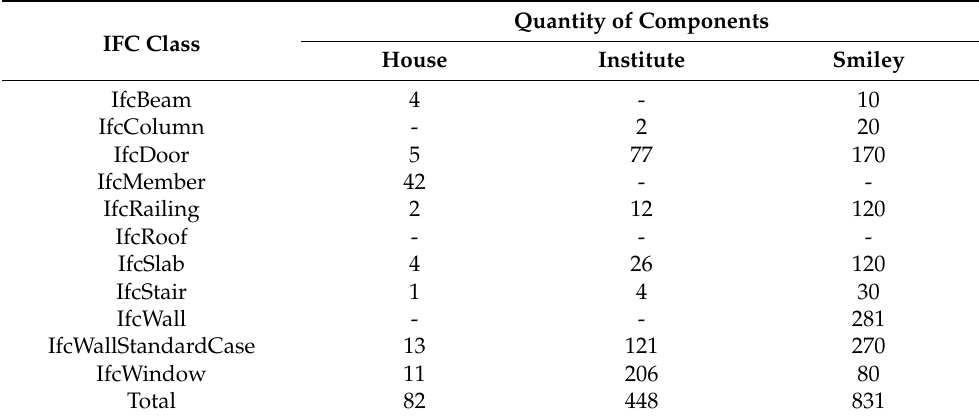
Figure 13. Models used, including ( a ) house model, ( b ) institute model and ( c ) Smiley building model. Table 5. Building elements and component quantity of the house model, institute model and Smiley building model.